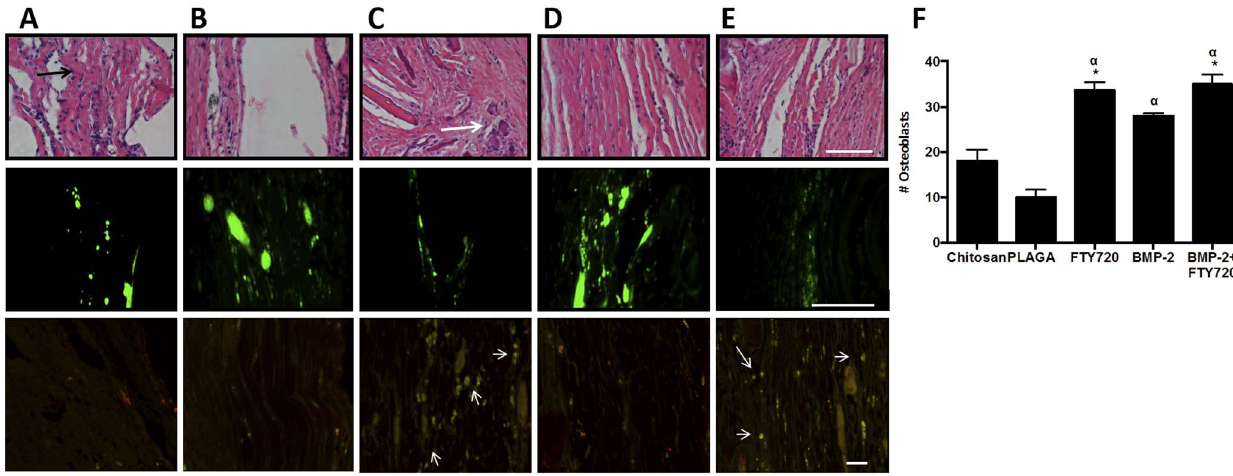
Figure 6. FTY720 enhances osteoblast number and reduces inflammatory cell recruitment in the defect region 9 weeks after injury. (A) Chitosan, (B) Chitosan + PLAGA microspheres, (C) Chitosan + PLAGA microspheres loaded with FTY720, (D) Chitosan loaded with BMP-2 and (E) Chitosan loaded with BMP-2 + PLAGA microspheres loaded with FTY720. Top row: Number of osteoblasts increases in the defect region after treatment with FTY720 (scale bar =100 um). The average number of osteoblasts after H&E staining is determined by counting cells around newly formed osteoid regions (black arrows). Representative H&E stain for bone growth in cranial defect at week 9 afterFTY720 treatment results in the formation of more osteoid regions in the defect area (white arrow). This is quantified from images taken from the center of the defect region (F) (*p , 0.05 compared to chitosan control; a p , 0.05 compared to PLAGA control). Middle row: FTY720 treatment reduces CD45 + inflammatory cells in defect (scale bar =500 um). Bottom row: FTY720 treatment leads to enhanced recruitment of CD90 + /CD29 + cells to the defect site (white arrows indicate co localization).